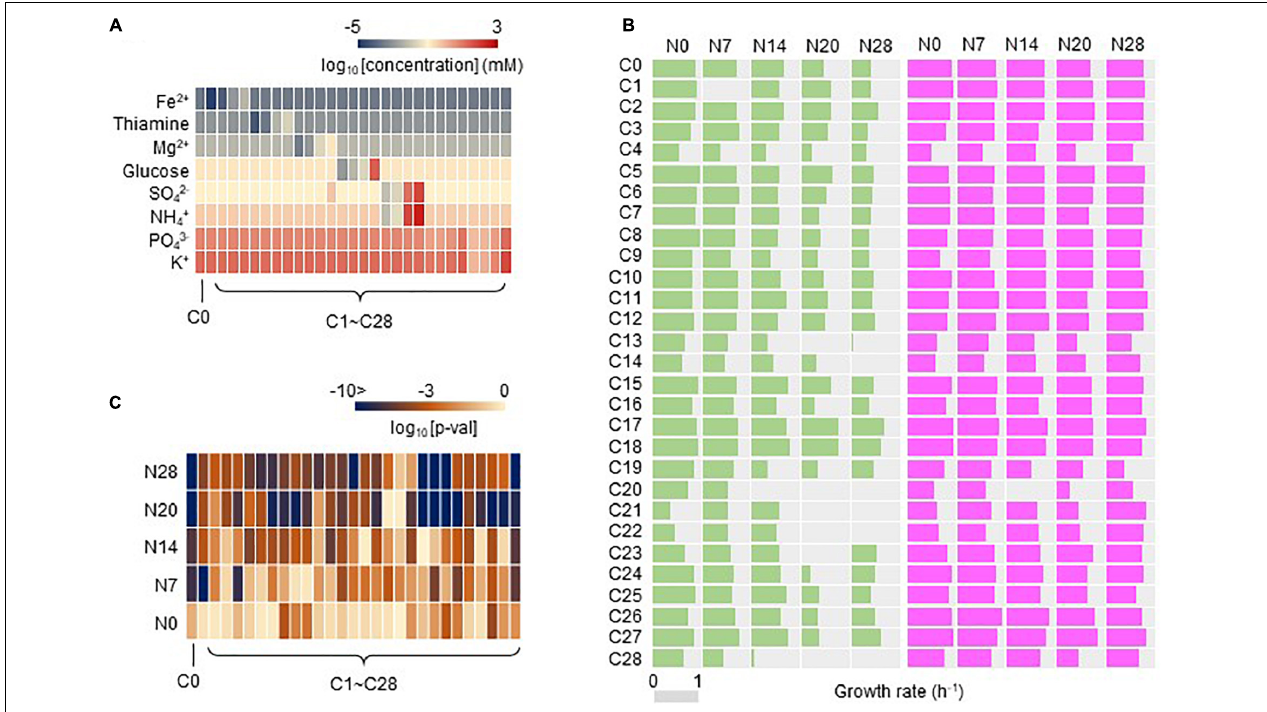
FIGURE 3 | Growth rates evaluated in 29 medium combinations. (A) Heatmap of the concentration gradient. The eight chemical components of the media are indicated. The gradation from red to blue indicates the concentration, which is shown on the logarithmic scale, from high to low. C0 is the environment for evolution. (B) Growth rates of Ancs and Evos in the environmental gradient. The growth rates evaluated in the 29 medium combinations are shown. Pink and green represent Evos and Ancs, respectively. The gray bar represents the scale of the exact growth rate (h – 1 ). (C) Heatmap of statistical significance of the changes in growth rate of Evos and Ancs. The gradation from light orange to dark blue indicates the p -value, which is shown on the logarithmic scale, from low to